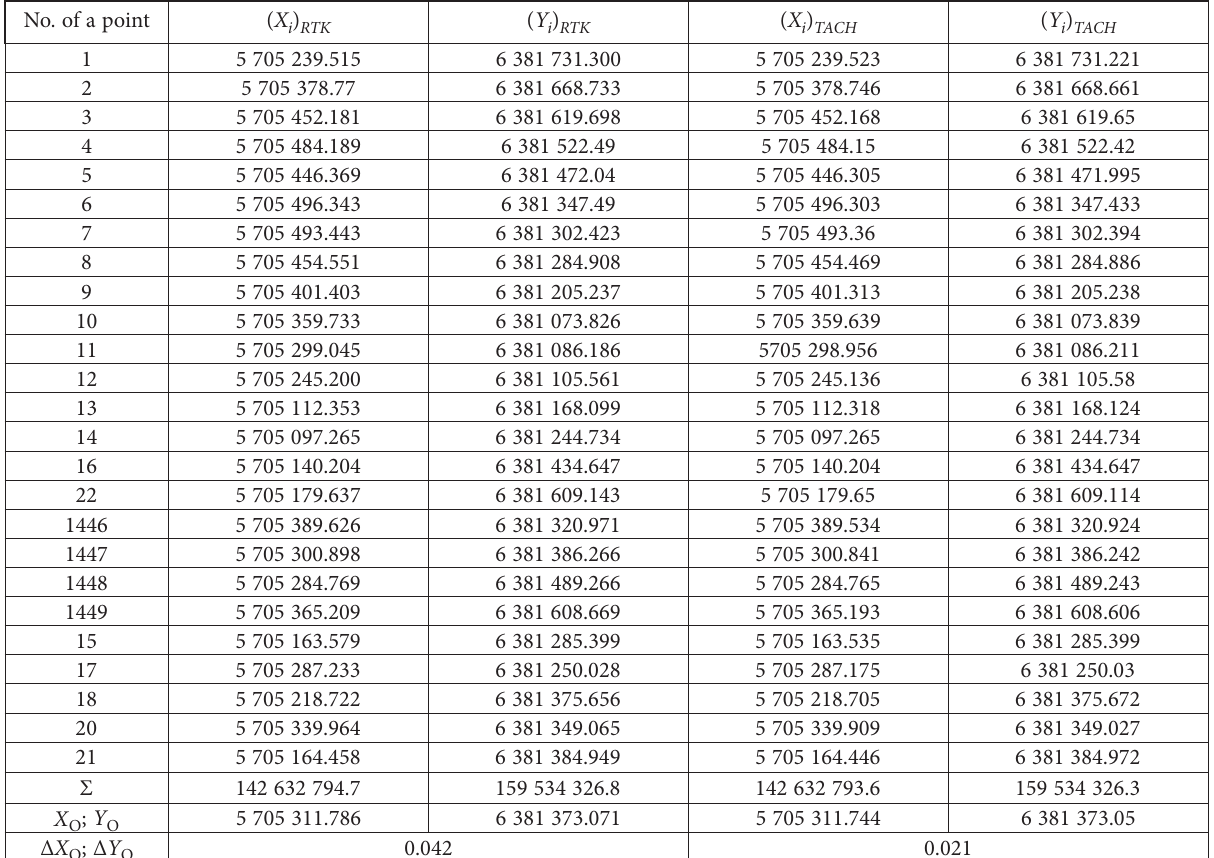
Table 1. Values of planned coordinates of points and center of gravity of the system of points No. of a